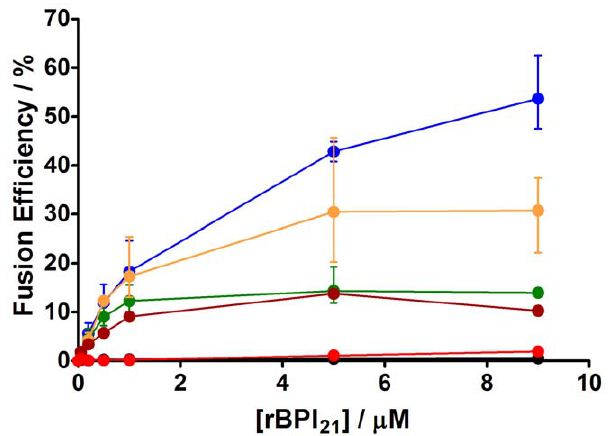
Figure 5. Zeta-potential for membrane model systems in the presence of rBPI 21 . Bars represent the zeta-potential range from at least two independent experiments. POPC (black circles); POPG (blue circles); POPC:POPG 55:45 (orange circles); POPC:POPG 80:20 (green circles); POPC:LPS 80:20 (red circles); POPC:POPG:LPS 60:20:20 (brown circles). The lipid concentration was kept constant at 200 m M. The differences in potential-zeta for [rBPI 21 ]/[Lipid] =0.015 were statistically significant for the following data pairs: POPC/POPC:LPS (80:20), POPC/ POPC:POPG (80:20), POPC/POPC:POPG (55:45), POPC/POPG, POPC/ POPC:POPG:LPS (60:20:20), POPC:LPS (80:20)/POPG; POPC:POPG (80:20)/POPG, POPC:POPG (55:45)/POPG and POPC:POPG:LPS (60:20:20)/POPG.